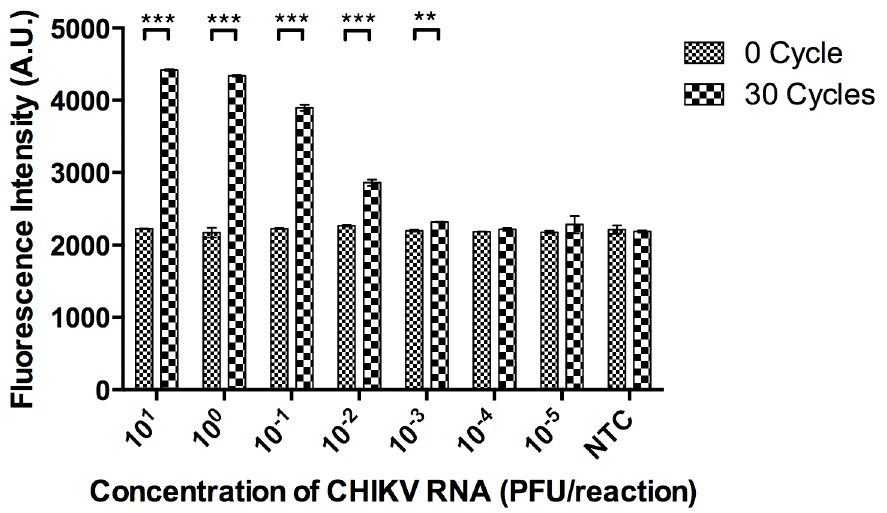
Fig 4. The detection limit of a DANP-anchored RT-PCR assay was determined using 10-fold serial diluted CHIKV genomic RNA. The detection limit for the assay was equivalent to 0.001 PFU per reaction of CHIKV. Data are shown as means SEM of three experiments. *** P < 0.001, ** P < 0.01 by Student ’ s